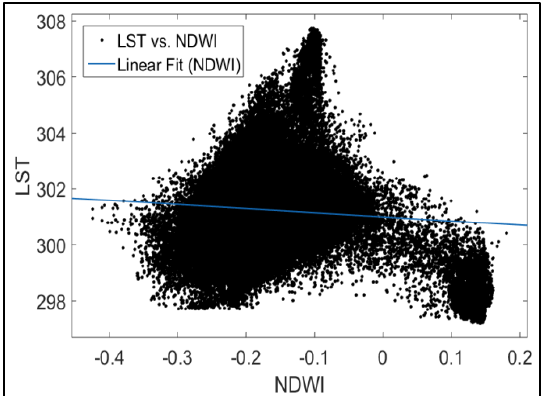
Figure7. LST-NDVI relation with land cover Figure 6.Scatter plot of LST with NDWI Waterbodies has lower LST but shows negative values of NDVI and other land covers shows positive values. The Indices Slope vegetative land covers shows higher positive values than bare soil and urban regions but lower LST values. This explains the non-linear behaviour of LST with NDVI. Since, urban areas also include soil, vegetation and water, NDVI cannot explain LST in urban regions due to greater heterogeneity in land cover. But agricultural region contains only bare soil and vegetation, so NDVI can explain LST better in agricultural regions. Table3. Regression parameters for LST relation with indices